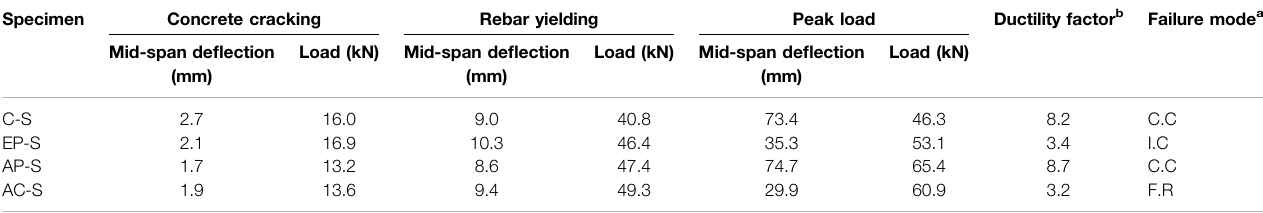
TABLE 4 | Characteristic values of static tests. Specimen